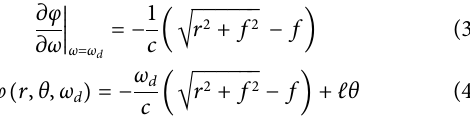
Frontiers in Physics |